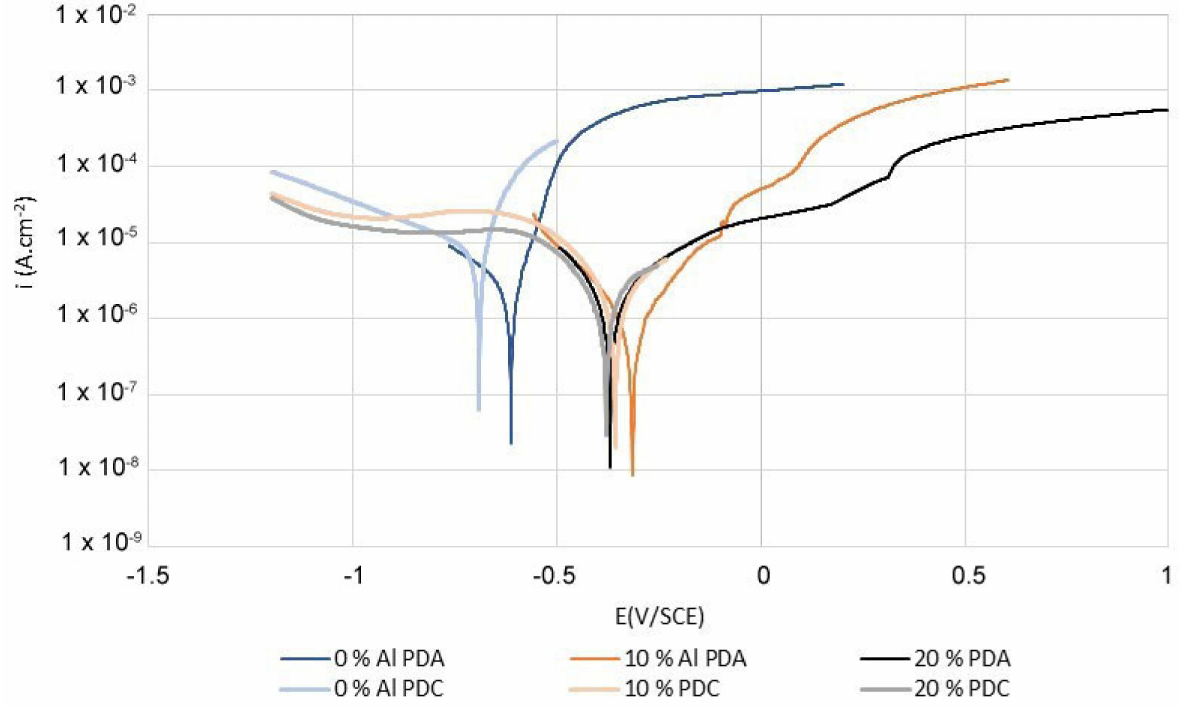
Figure 2. Comparison of PDA curves in potable water.